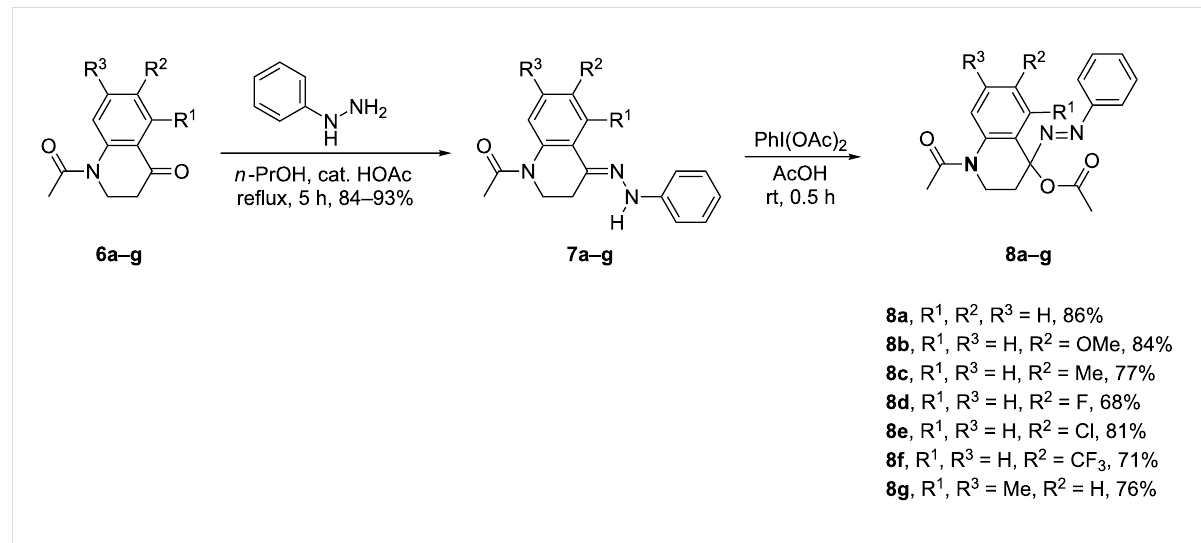
Scheme 2: Synthesis of α -acetoxyazo compounds 8a – g . Reaction conditions: for synthesis of 8a : 7a (10.42 mmol), PhI(OAc) 2 (12.50 mmol), AcOH (10 mL); for synthesis of 8b – g : 7b – g (0.71 mmol), PhI(OAc) 2 (0.85 mmol), AcOH (1 mL). b Isolated yield. c Ratio of E/Z isomers was not